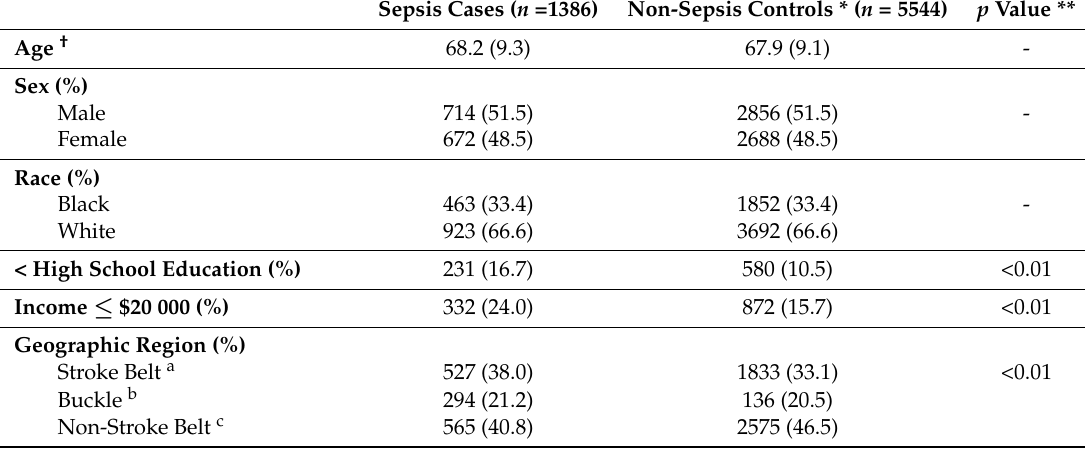
Table 1. Comparison of demographic, substance use, and comorbidity characteristics between sepsis cases and controls. Among 1386 sepsis cases and 5544 controls matched on age ( ± 5 years), race, and